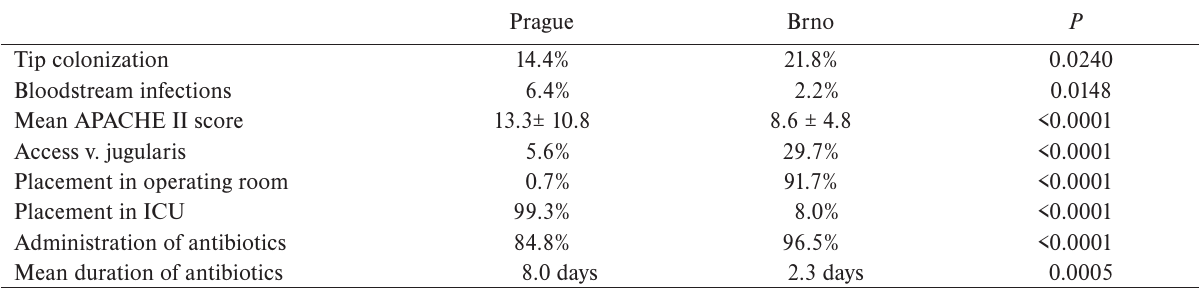
Table 4. Differences in the incidences of catheter tip colonization and bloodstream infection, APACHE II score, insertion sites and placement locations and antibiotics between the two study centers.